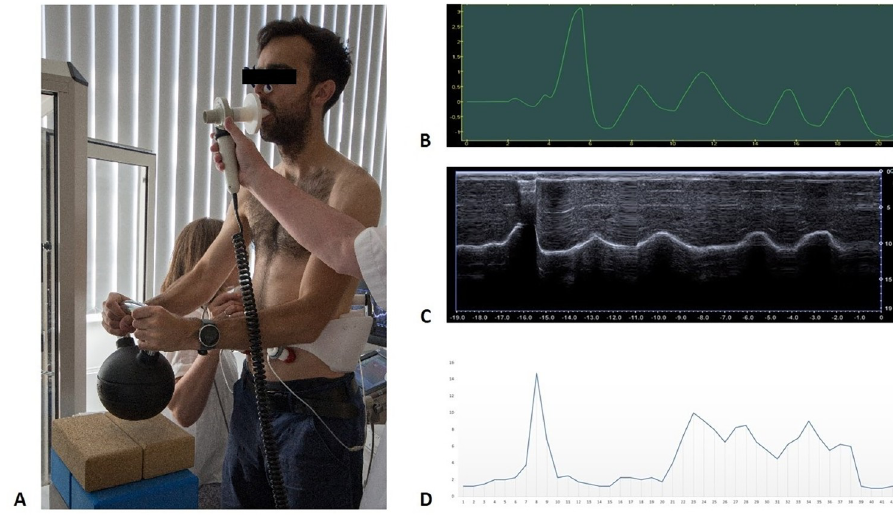
Fig 1. Examination procedures. ( A ) Participant assessed simultaneously by M-mode ultrasonography, spirometry, and DNS brace. ( B ) Spirometry record displayed in Grapher software ( C ) M-mode view of diaphragm motion. ( D ) Graphical representation of recorded data from DNS Brace. All of these recordings were taken during the same examination of one participant in Scenario 2.